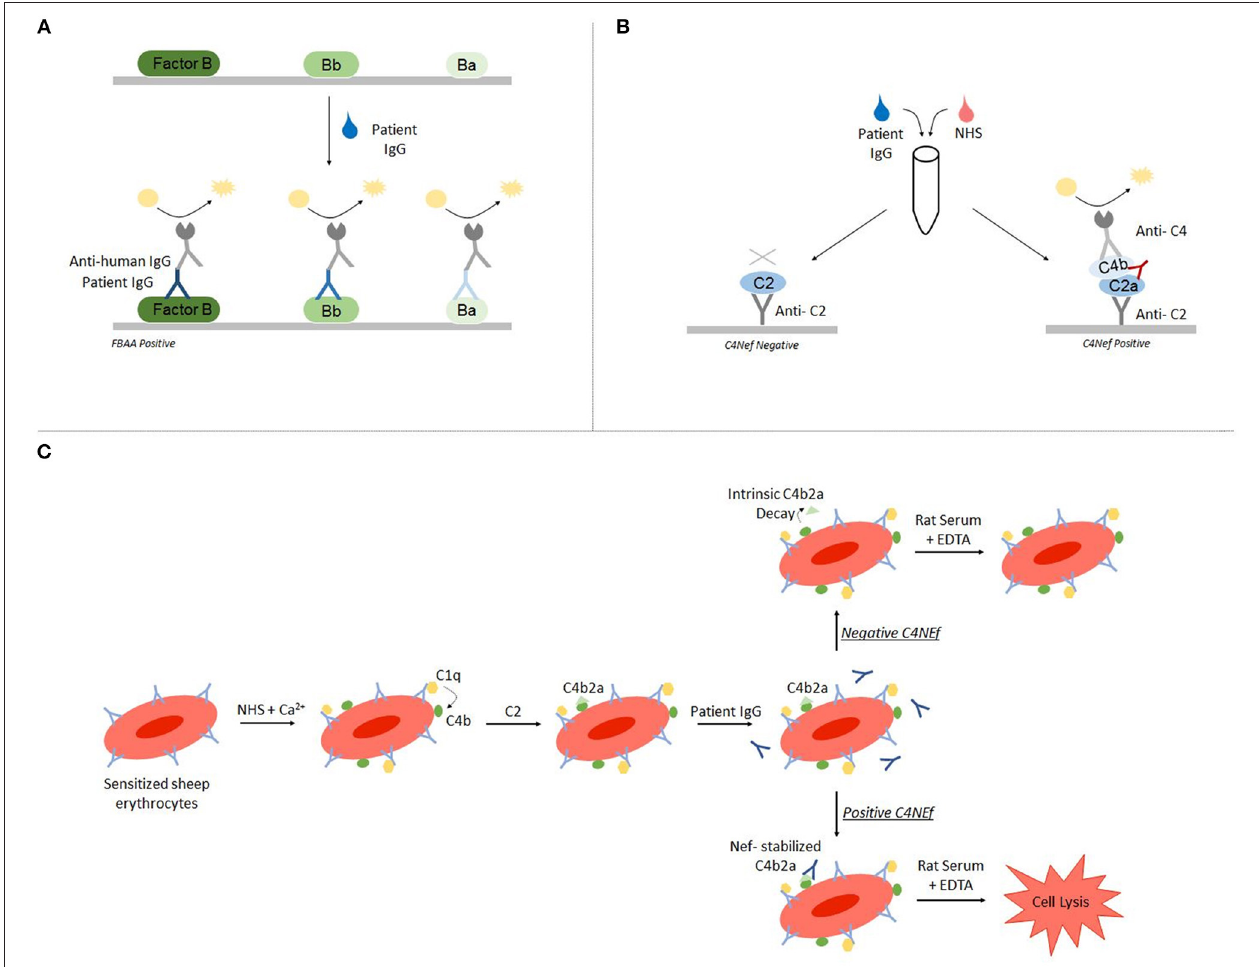
FIGURE 2 | Autoantibody detection is performed using ELISA-based and hemolytic-based assays. Factor B autoantibodies can be detected using an ELISA-based method (A) . C4 nephritic factors can be detected using either a sandwich ELISA (B) or a hemolytic assay (C)